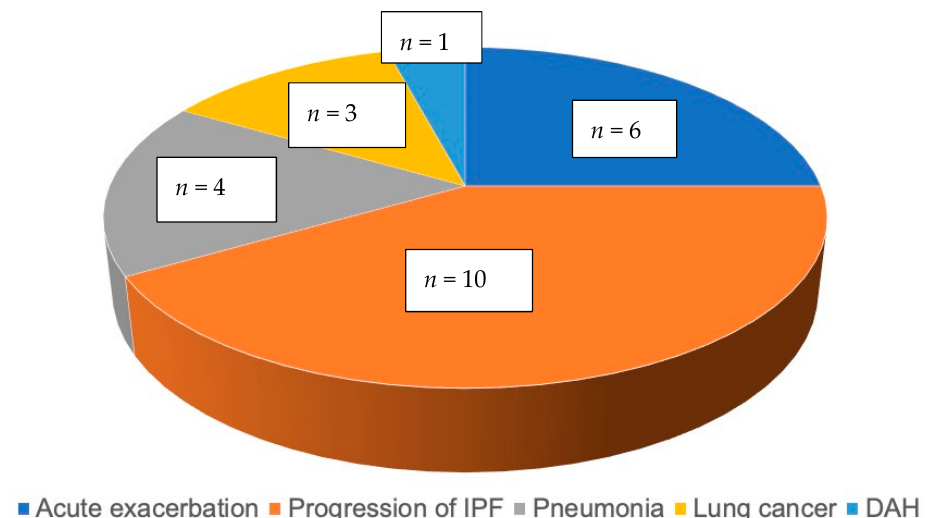
Figure 2. Causes of death ( n = 24). Abbreviations: IPF; Idiopathic pulmonary fibrosis, DAH; diffuse alveolar hemorrhage.